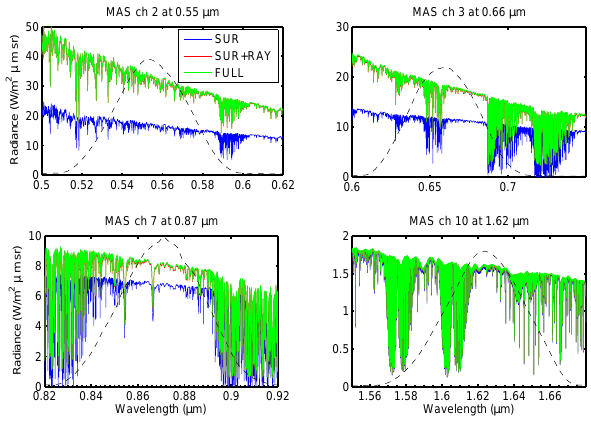
Fig. 6. High resolution spectral radiance in four MAS channels: channel 2 (top left), channel 3 (top right), channel 7 (bottom left) and channel 10 (bottom right). The colour coding is same for all the panels: the blue line labeled SUR is the case when the surface is the sole source function with a molecular atmosphere that only ab- sorbs radiance; the red curve labeled (SUR+RAY) is radiance after molecular scattering is added; the green line (FULL) considers also the presence of aerosol as source function and absorber. The dashed black line is MAS Relative Response Function on a relative